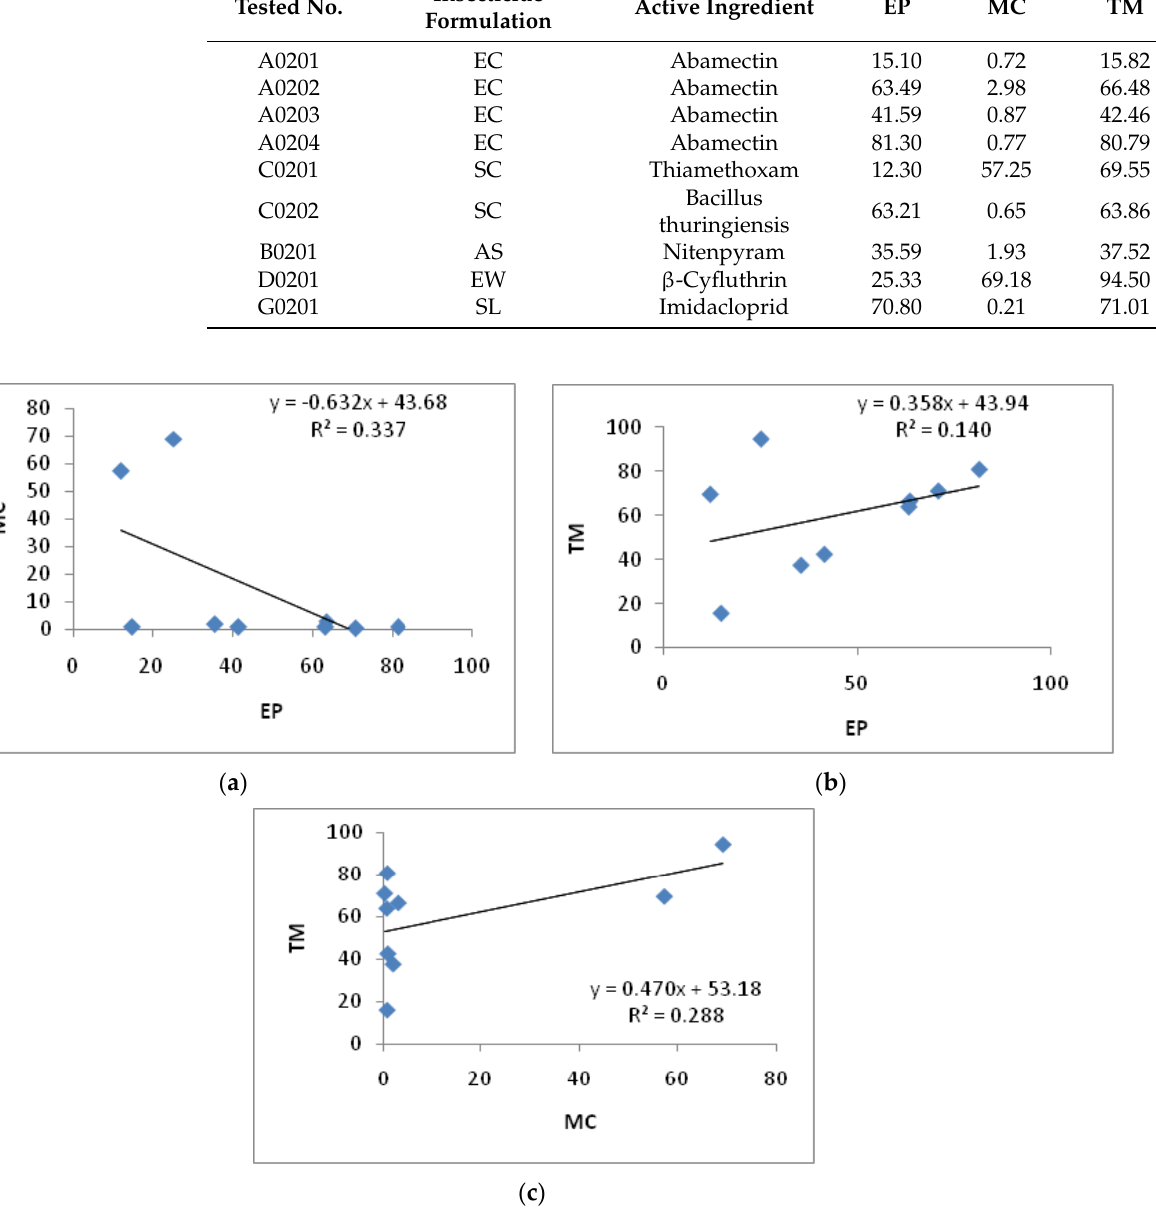
Table 4. Actual emission ratio of total VOCs during applied typical insecticides. Tested No.